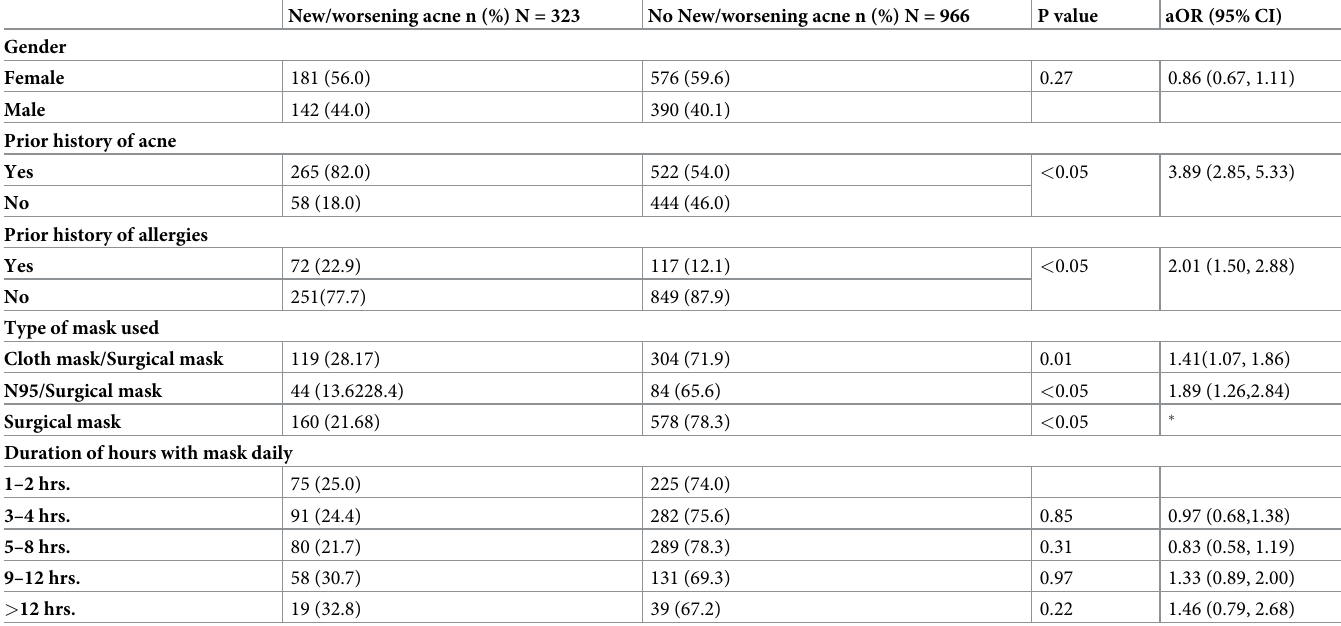
Table 2. Risk factors to development of new or worsening